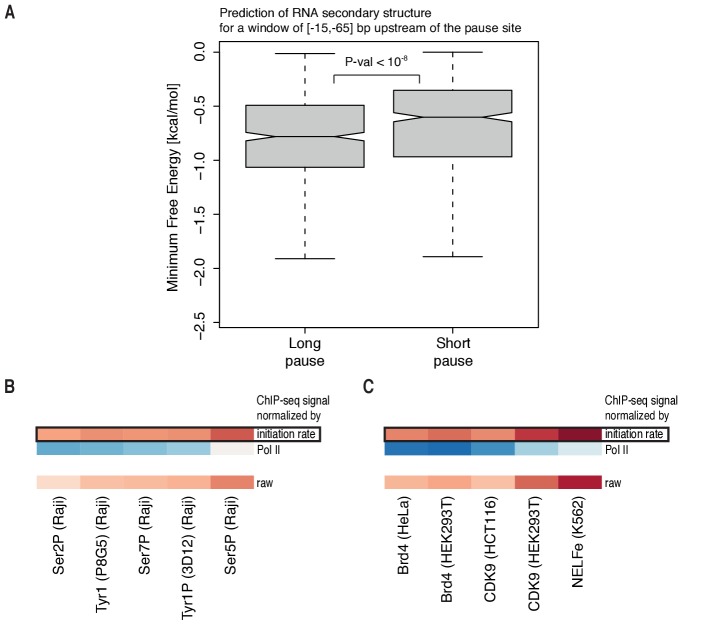
Features of promoter-proximal pausing.(A) Distributions of gene-wise mean minimum free energy (Materials and methods) for a window of [−15,–65] bp upstream of the pause site for TUs with long pause durations (pause duration >75% quantile, 534 TUs) and TUs with short pause durations (pause duration <25% quantile, 534 TUs). (B) Heatmap showing the pairwise Spearman correlation (color encoded, −0.12 in blue to 0.15 in red) using ChIP measurements of Pol II phospho-isoforms S2P, S5P, S7P and T1P in the pause window against the pause duration in three different variants: ChIP measurements normalized to productive initiation rate (initiation rate), normalized to total Pol II (Pol II), raw signal (raw). (C) Heatmap as in (B) using ChIP measurements of CDK9, NELFe and Brd4 (color encoded, −0.19 in blue to 0.22 in red) (Supplementary file 1).